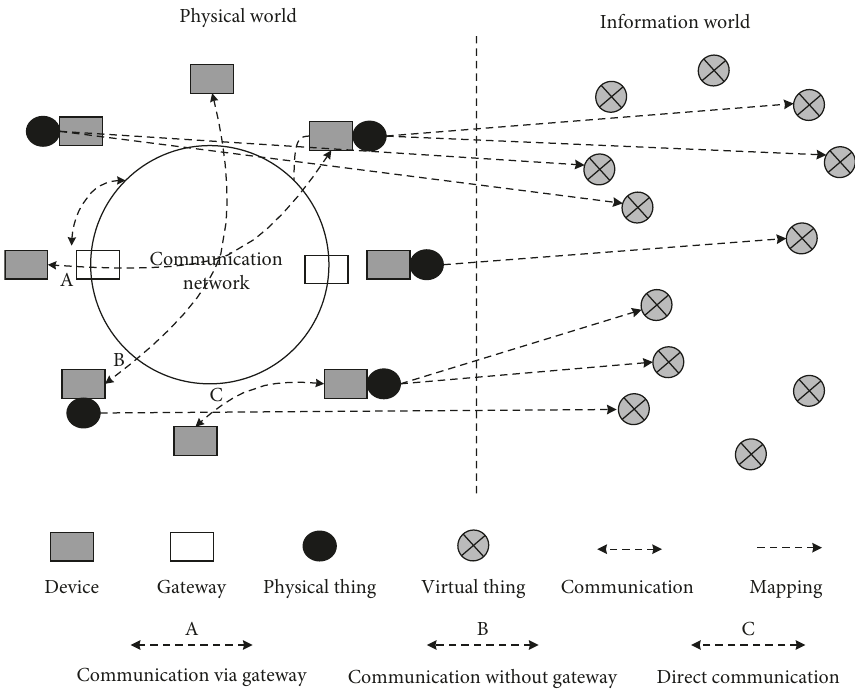
Figure 1: IoT communication